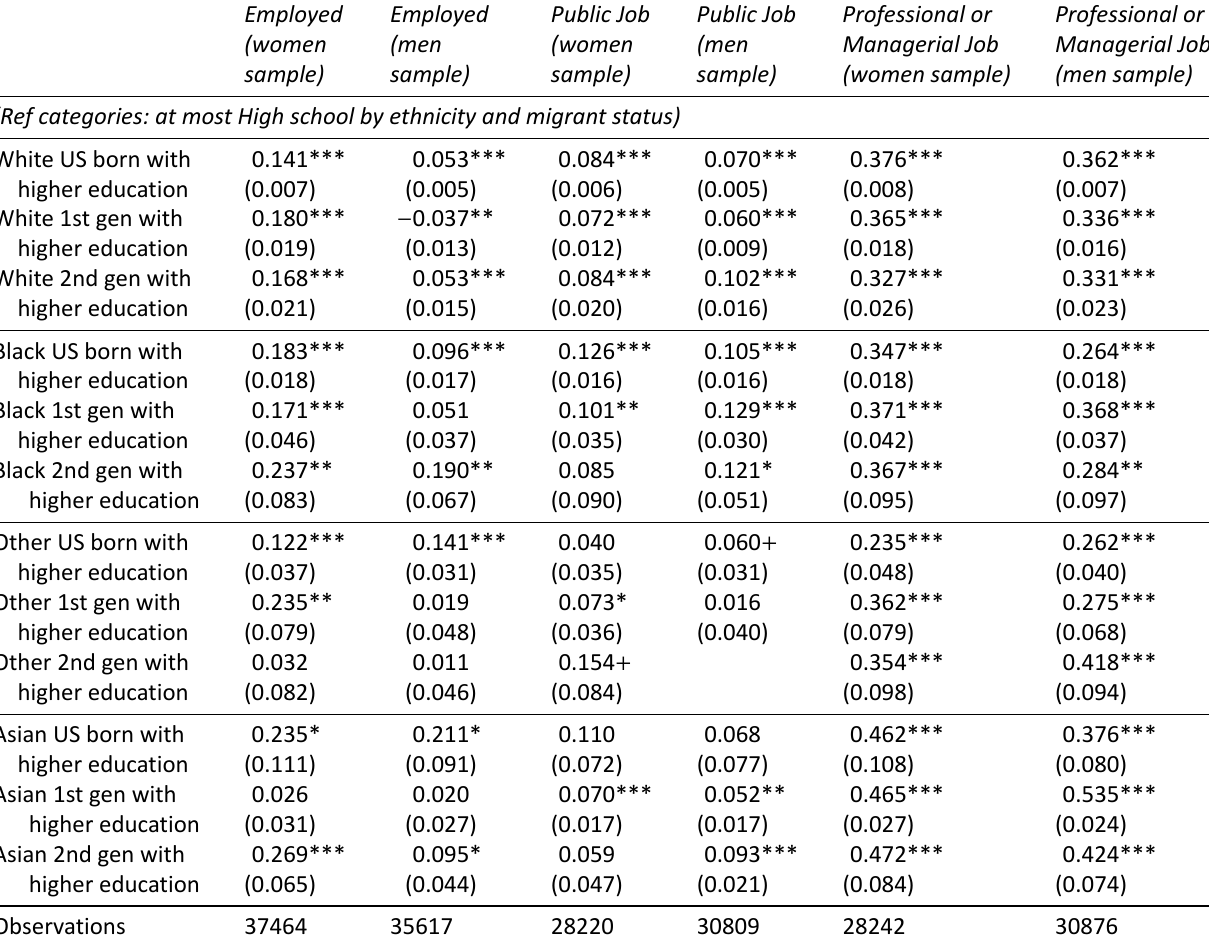
Table 3. Returns to high education by ethnicity and migrant status. Source: US Census Bureau